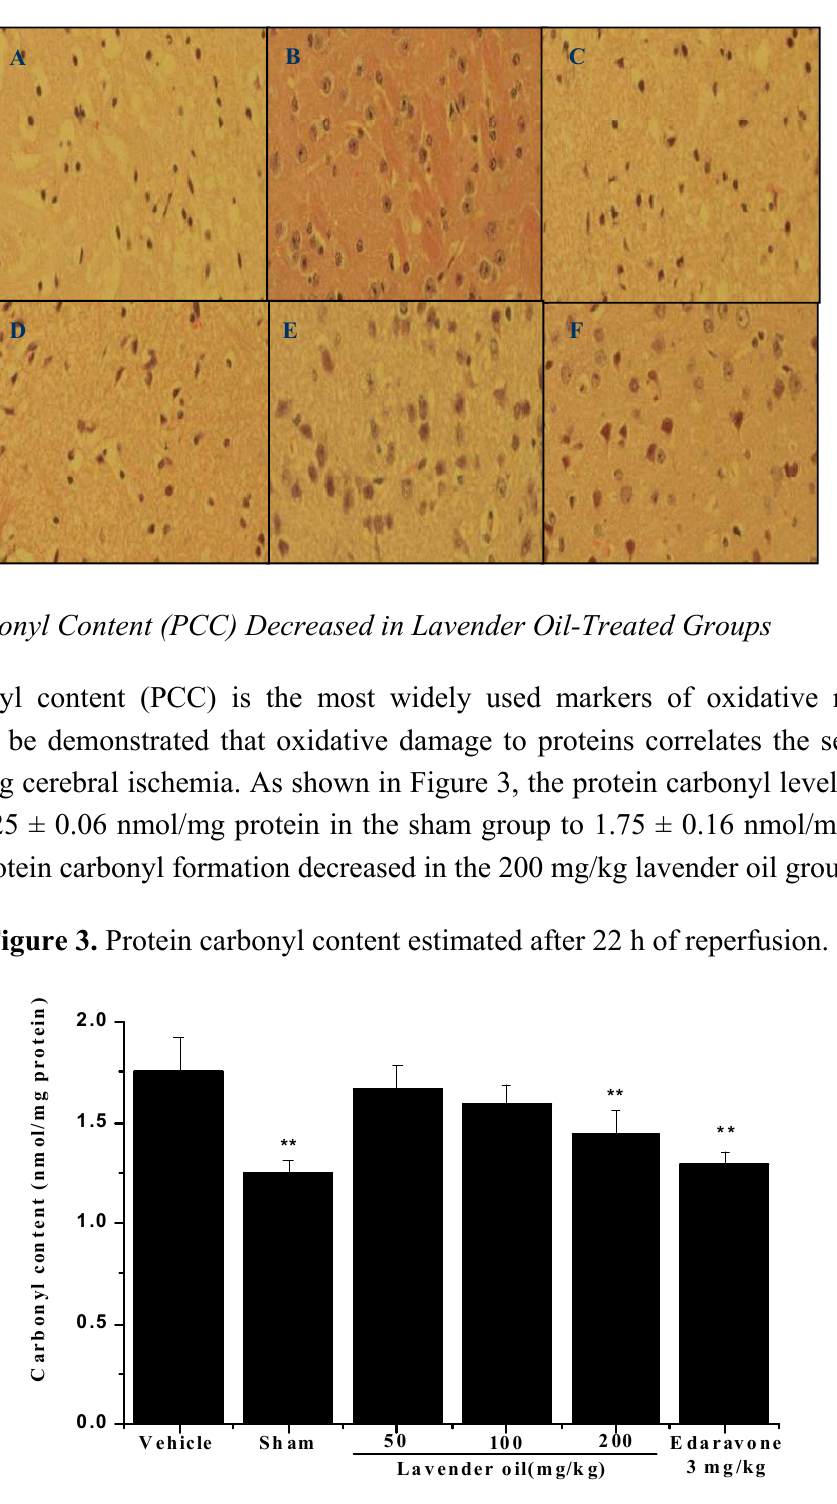
Figure 2. Representative coronal sections stained with hematoxylin-eosin (HE) after 22 h of reperfusion (×400 magni fi cations). ( A ) Vehicle group; ( B ) Sham group; ( C ) Lavender oil-treated group (50 mg/kg); ( D ) Lavender oil-treated group (100 mg/kg); ( E ) Lavender oil-treated group (200 mg/kg); ( F ) Edaravone-treated group (3 mg/kg). A B